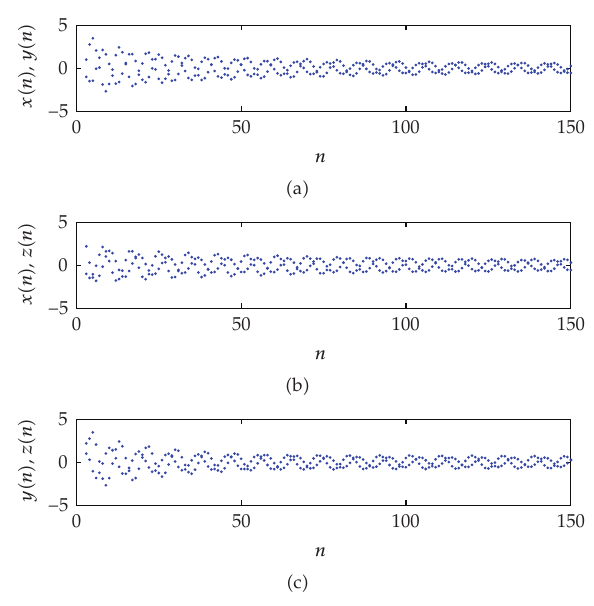
Figure 3: Three waveforms have 2 π/ 3 ω out of